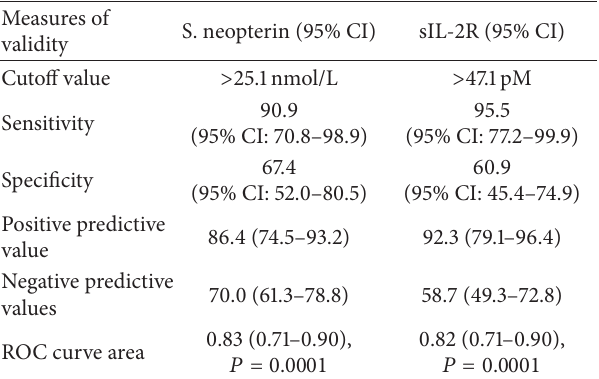
Table 4: Measures of validity and roc curve area of neopterin and sIL-2R in relation to the CD4 cell count < 200 cells/ 𝜇